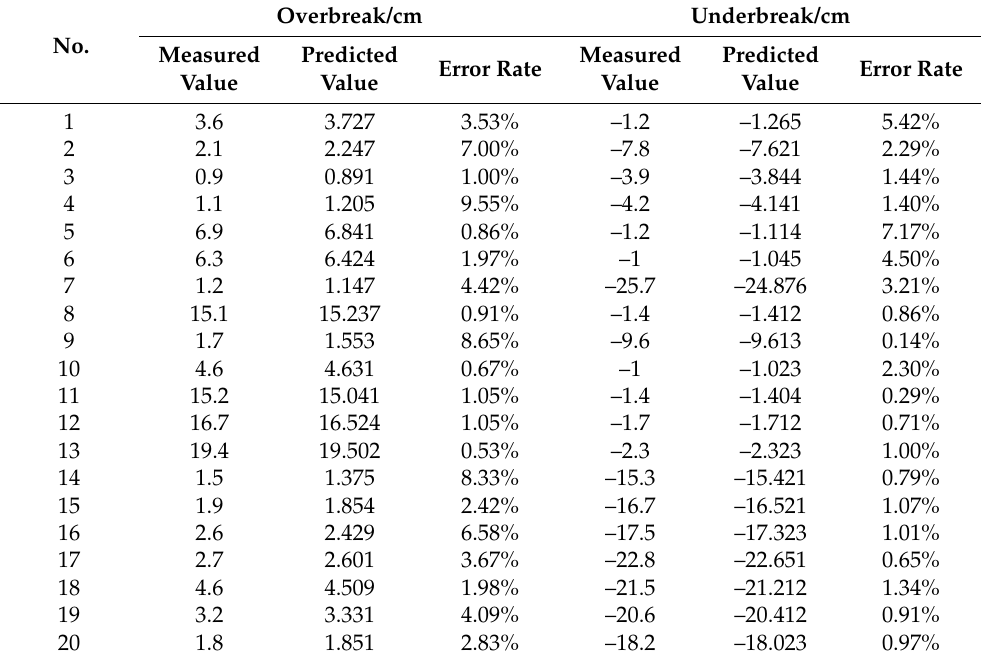
Table 4. The accuracy of the prediction in testing data.